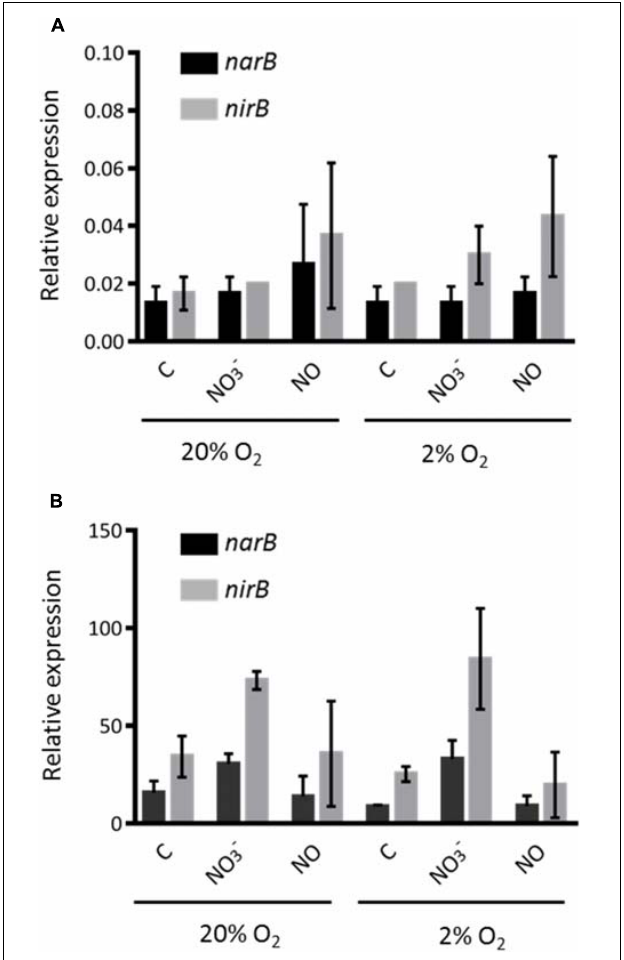
FIGURE 3 | Expression level of nirB and narB genes. (A) S. meliloti WT strain was grown to exponential phase in Vincent minimal medium (with NH 4 Cl) (OD 600 = 0.2–0.3). Cells were then exposed (1.5 h) to a NO donor (25 µ M spermineNONOate) or nitrate (20 mM KNO 3 ) in aerobic (20% O 2 ) or microaerobic (2% O 2 ) conditions. Cells were recovered by filtration and frozen in liquid nitogen. RNA was extracted and transcript levels of narB (black bars) and nirB (gray bars) were determined by qRT-PCR. Transcript levels were normalized by using SMc01171 as a reference gene. (B) S. meliloti WT strain was grown as in (A) except that NH 4 Cl was removed from the medium by centrifugating cells and resuspending them in Vincent minimal medium without NH 4 Cl before exposing cells to the different conditions tested. All values shown are the means and standard errors of the mean of data from three independent experiments (two technical repeats for each experiment).